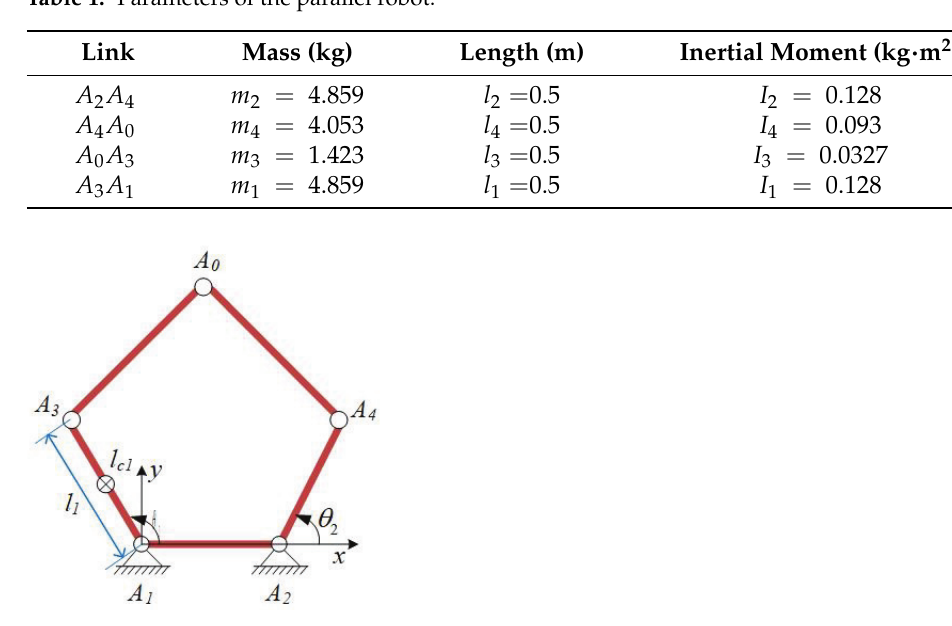
Figure 2. The structure diagram of the considered